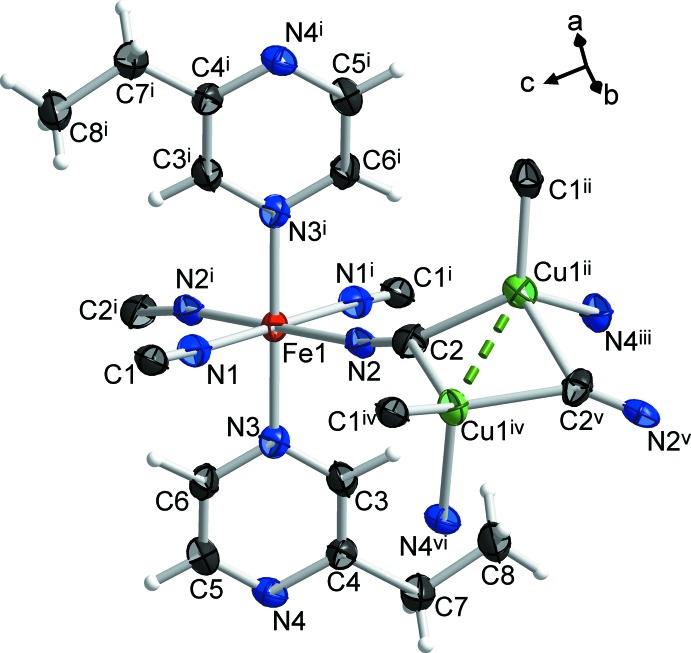
A fragment of the crystal structure of the title compound with atom labelling. Displacement ellipsoids are drawn at the 90% probability level [symmetry codes: (i)  − x,  − y, 1 − z; (ii) x, −y, − + z; (iii) x, 1 − y, − + z; (iv) 1 − x, −y, 1 − z; (v) 1 − x, y,  − z; (vi) 1 − x, 1 − y, 1 − z]. The Cu⋯Cu short contact is shown as a dashed line.